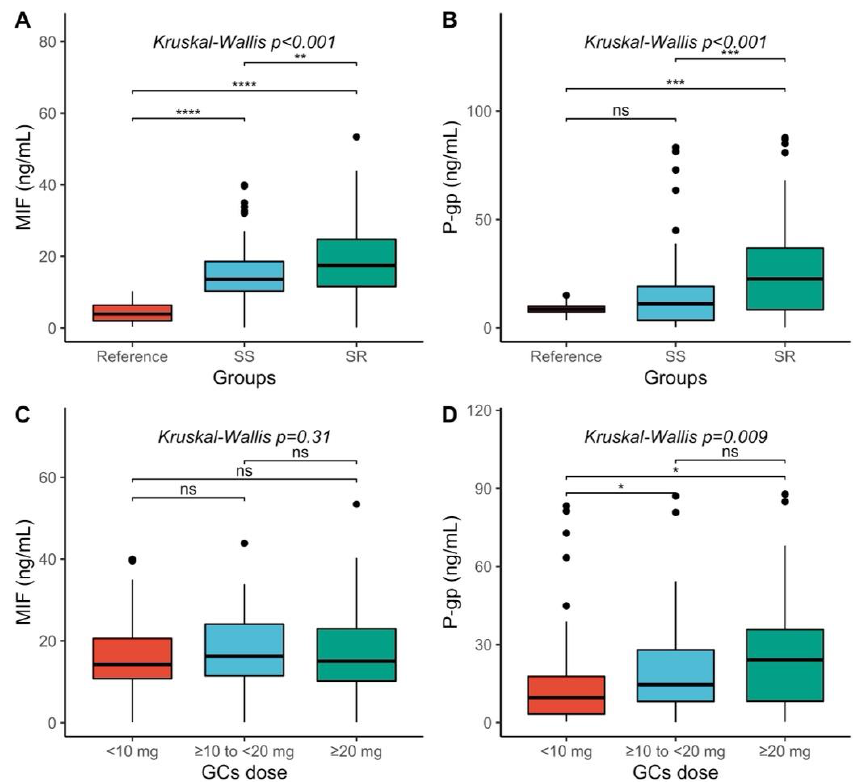
Figure 1. Comparison of MIF and P-gp serum levels; ( A ) comparison of the MIF serum levels among study groups; ( B ) comparison of P-gp serum levels among study groups; ( C ) comparison of MIF serum levels by GCS doses; ( D ) comparison of P-gp serum levels by GCS doses. ****: p -value ≤ 0.00001; ***: p -value ≤ 0.001; **: p - value ≤ 0.01; *: p - value ≤ 0.05; ns = not significant. SS, Steroid Sen- sitive; SR, Steroid Resistant.